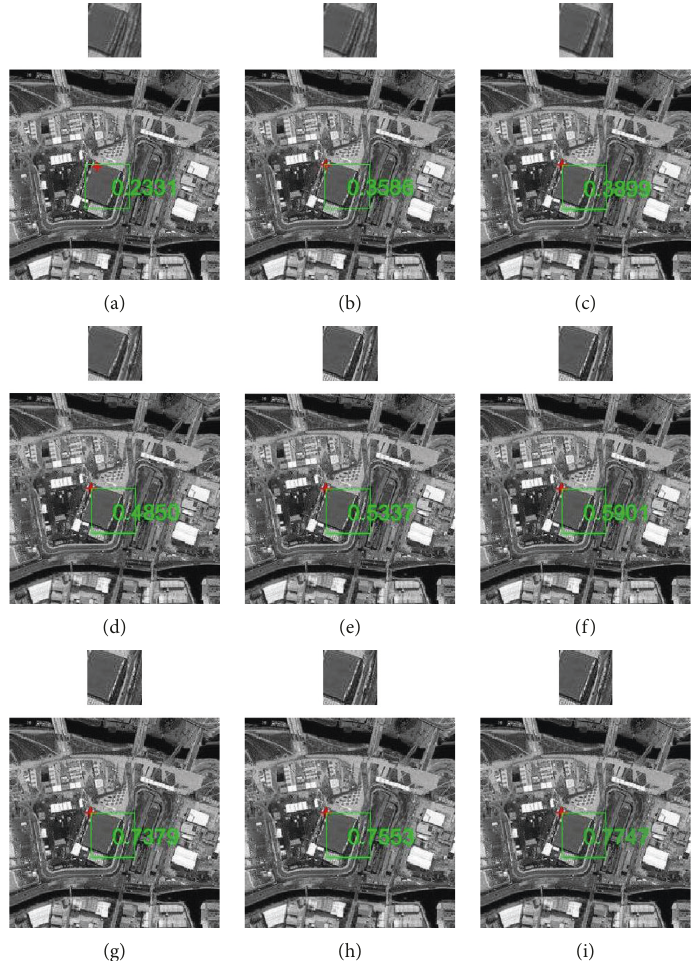
Figure 2: An example of our JDM-BISR approach. For each iteration, the small image represents the restored images and the big image gives the matching results, where the red cross ( + ) represents the top-left coordinate of the ground truth of the matching position, the green rectangle denotes the predicted matching position, and the value denotes the confidence. (a) Initialization. (b) Iteration 1. (c) Iteration 2. (d) Iteration 3. (e) Iteration 4. (f) Iteration 5. (g) Iteration 6. (h) Iteration 7. (i) Iteration